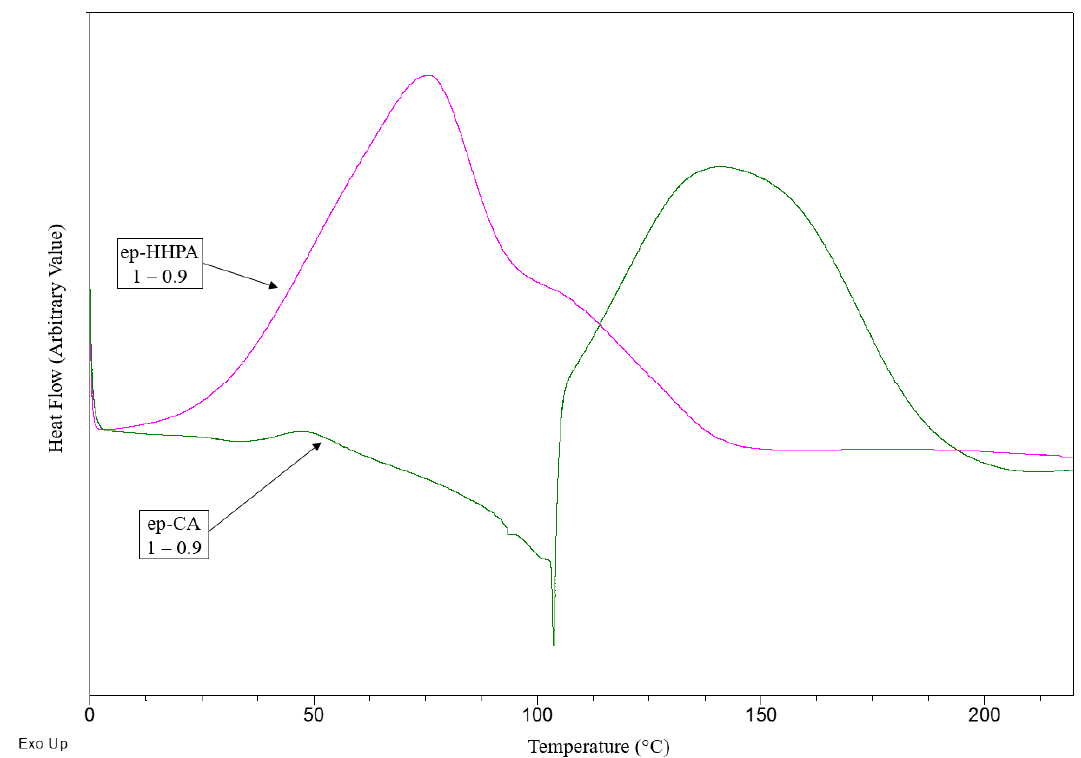
Figure 2. Curing of BioIgenox using CA or HHPA as a hardener.